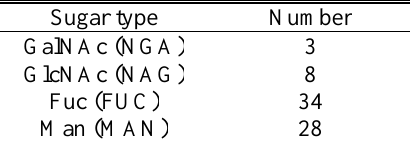
Table 1 Number of O -glycosylation sites from the Protein Data Bank Sugar type Number GalNAc